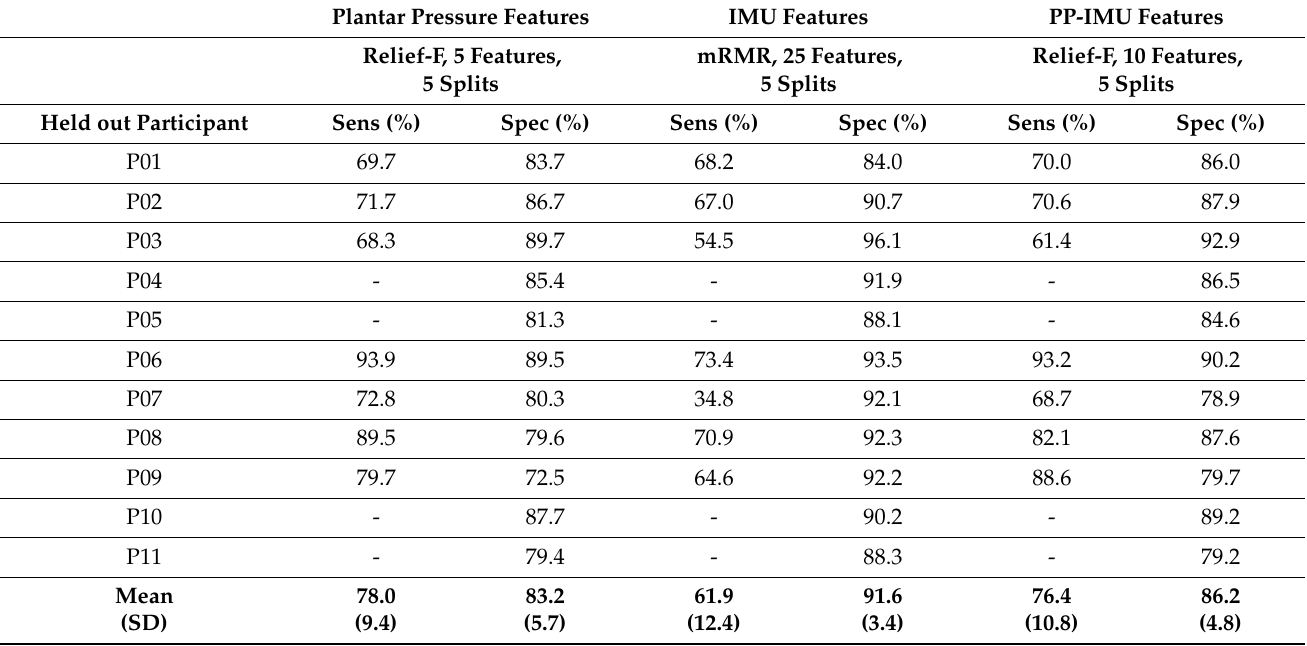
Table 4. Top-performing random undersampling (RUS)-boosted ensembles of decision trees. Target class is Total-FOG (Case 1). Mean and SD exclude nonfreezers (P04, P05, P10,